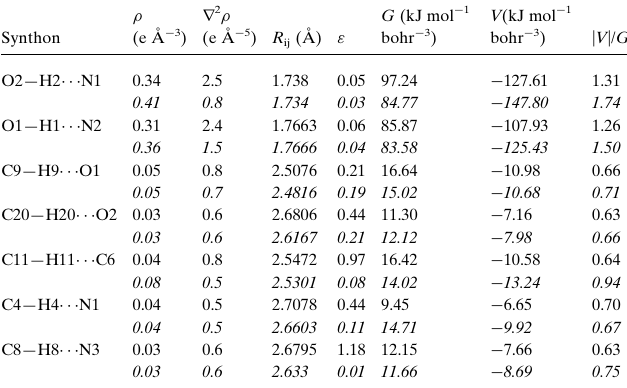
Table 3 Numerical (top) and graphical (bottom) comparison of the topological parameters, SBFA and theory (italics), of form II . Synthon